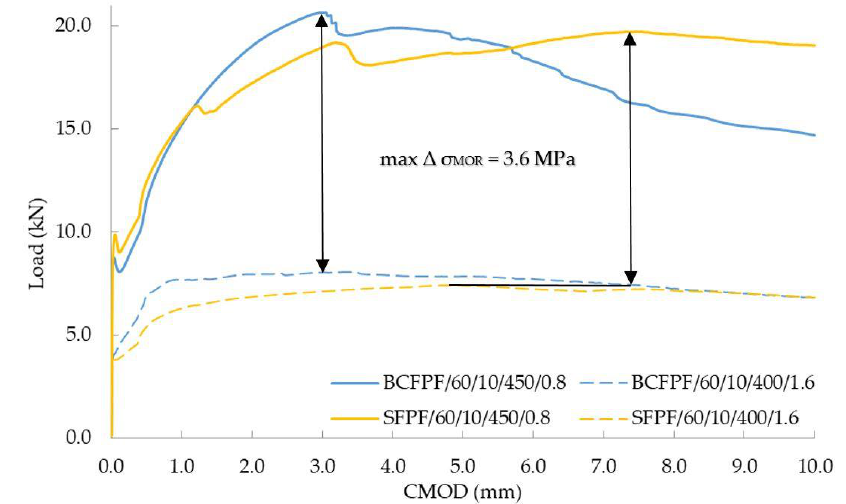
Figure 16. Load—CMOD (crack mouth opening displacement) relationship graphs for fiber-reinforced soil-cements with maximum σ MOR differential stress values.